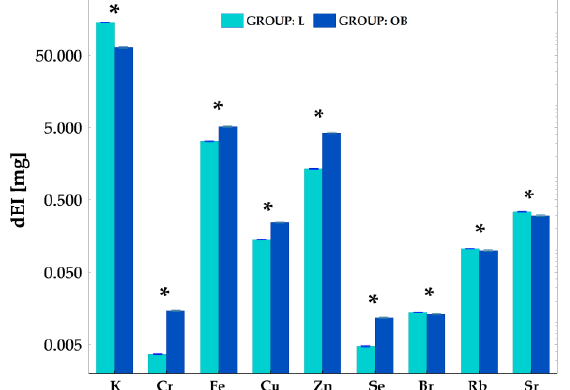
Figure 4. The comparison of the average daily intake of elements with food (dEI) (mg) between lean intact (L) and obese (OB) individuals. *—statistically significant correlation (at the p -levels < 0.05).